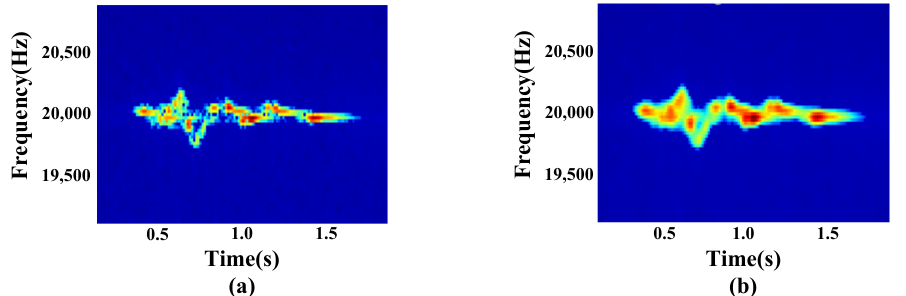
Figure 5. Single gesture action data processing process. ( a ) Bandpass filtering data; ( b ) Gaussian smoothing